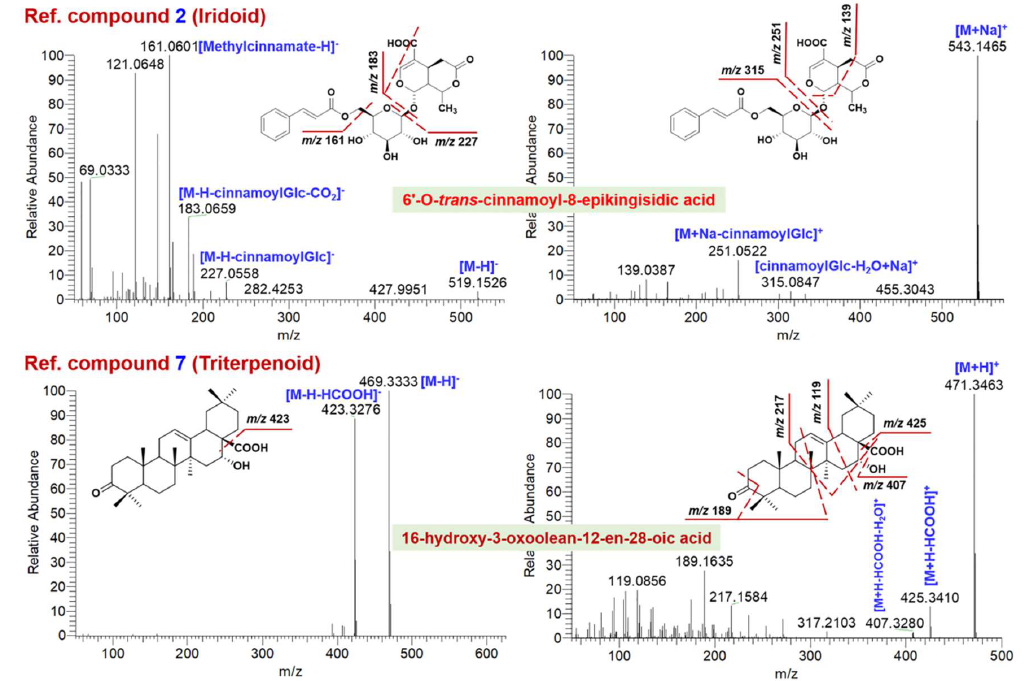
Figure 2. Annotation of the HCD-MS 2 data for reference compounds 2 (Iridoid) and 7 (Triterpenoid) obtained in both negative and positive ESI modes.